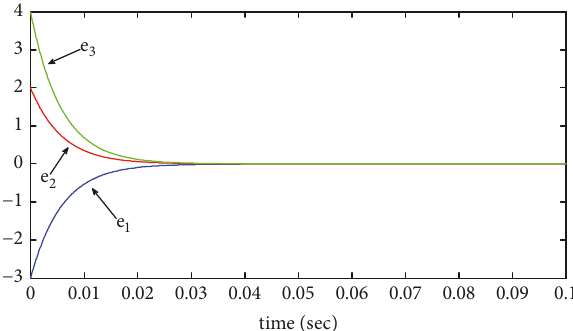
Figure 6:Timeevolution of synchronization errorsignals 𝑒 1 , 𝑒 2 , and 𝑒 3